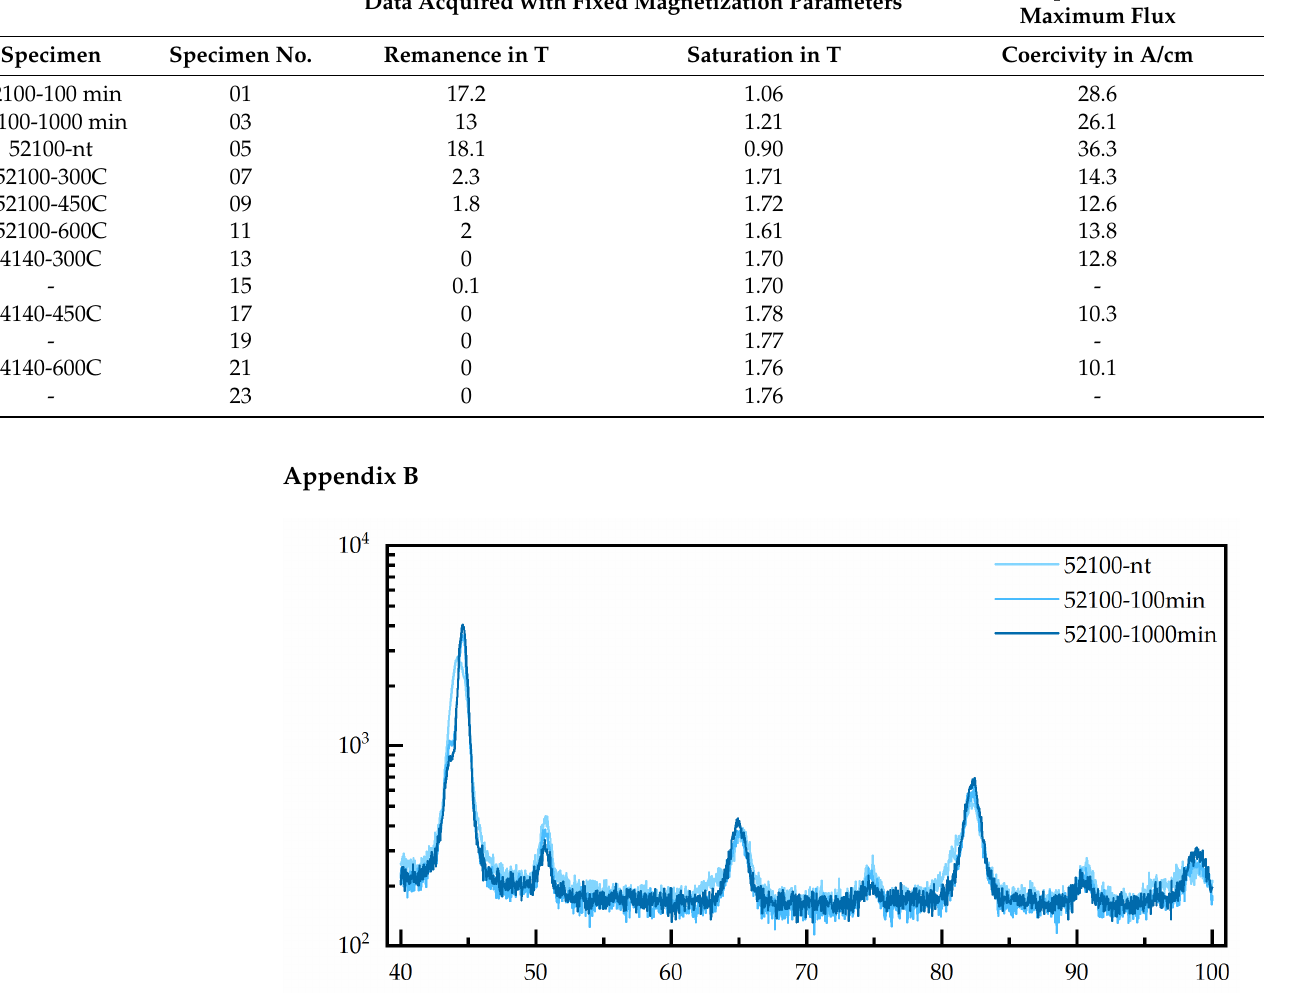
Table A2. Long specimen segments.